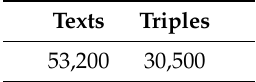
Table 10. Statistics of triple